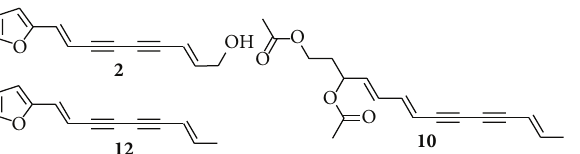
Figure 1: Structures of marker peaks 2 (atractylodinol), 10 ((4E,6E,12E)-tetradecatriene-8,10-diyne-1,3-diyl diacetate), and 12 (atractylodin).